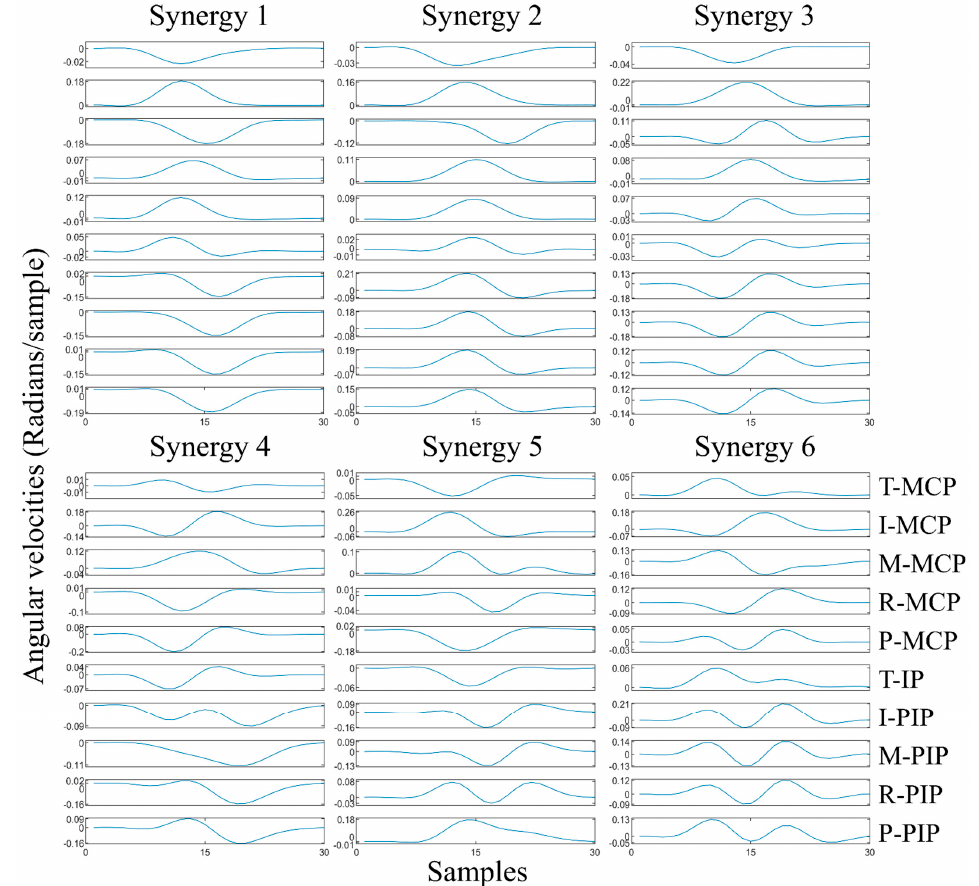
Figure 2. Six kinematic synergies of each hand joint derived from the training group of 5 subjects. T: thumb, I: index, M: middle, R: ring, P: pinky, MCP: metacarpophalangeal, IP: interphalangeal, PIP: proximal interphalangeal.